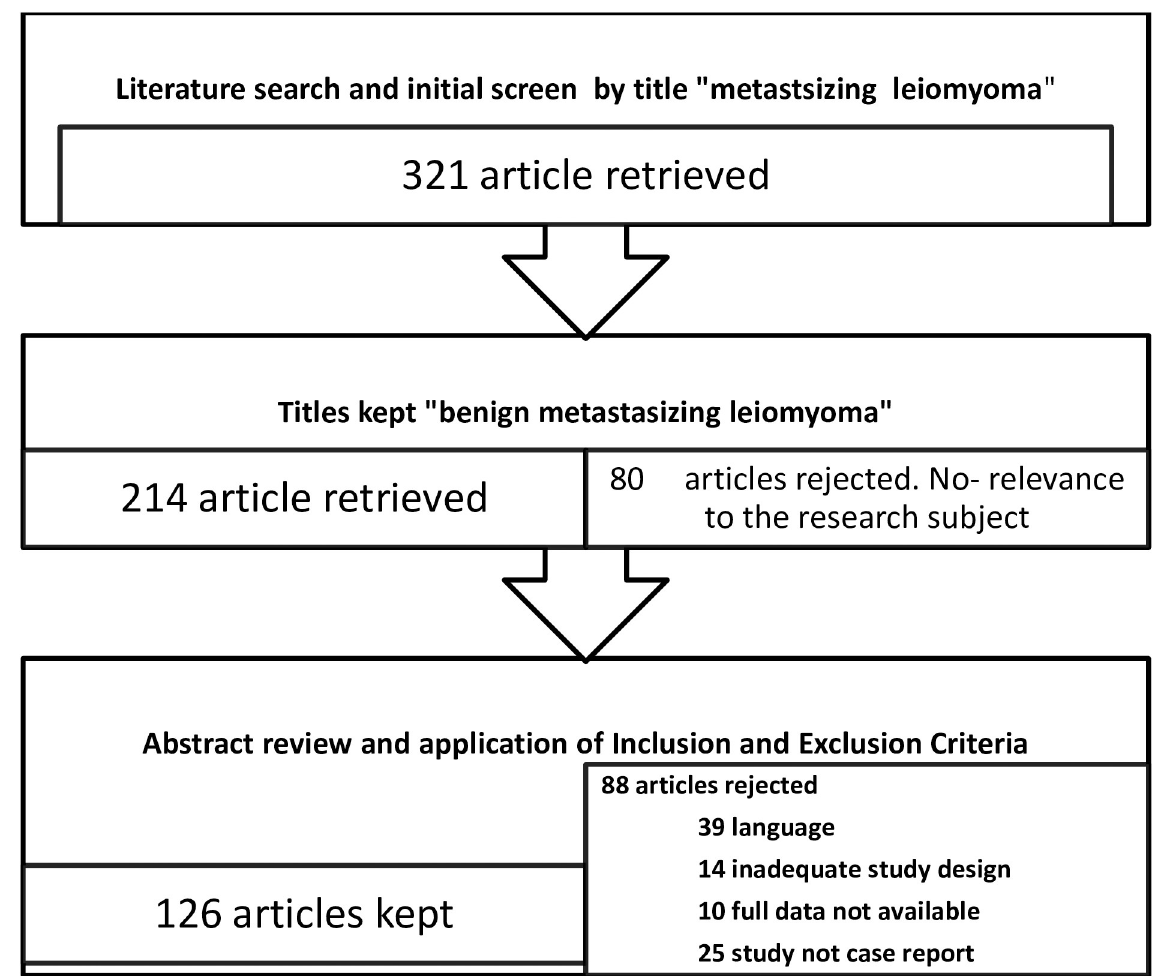
Fig 2. Summaryof retrieval and review of articles on benign metastasizing leiomyoma, 1965–2016.